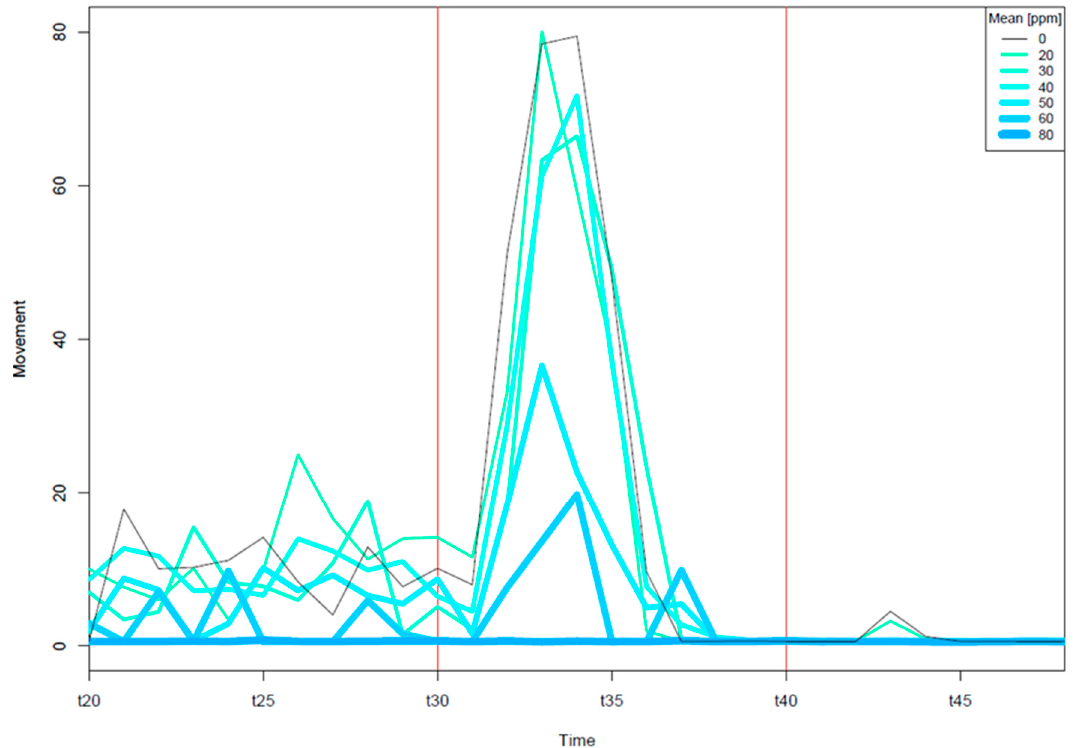
Figure 2. Embryonic photomotor response in embryos. Embryos were developmentally exposed and kept in the dark until 24 hpf. At 24 hpf, a typical photomotor response was exhibited (black line) with occasional movement in the dark and increases in excited movement after the pulse of light (red vertical line); there was little to no activity after the second pulse of light.